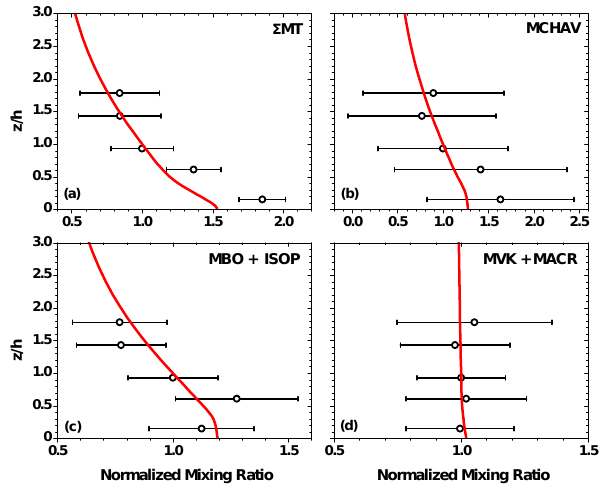
Fig. 2. Comparison of measured and modeled gradients of (a) to- tal monoterpenes, (b) methyl chavicol, (c) the sum of MBO and isoprene and (d) the sum of MVK and MACR. Both modeled and measured values are taken from the hot period. PTR-MS obser- vations represent the mean of six 5-min-averaged measurements at each height and are normalized by the 9.3m mixing ratios; error bars represent standard deviations. Model profiles are normalized to their canopy-top values ( z/h = 1).